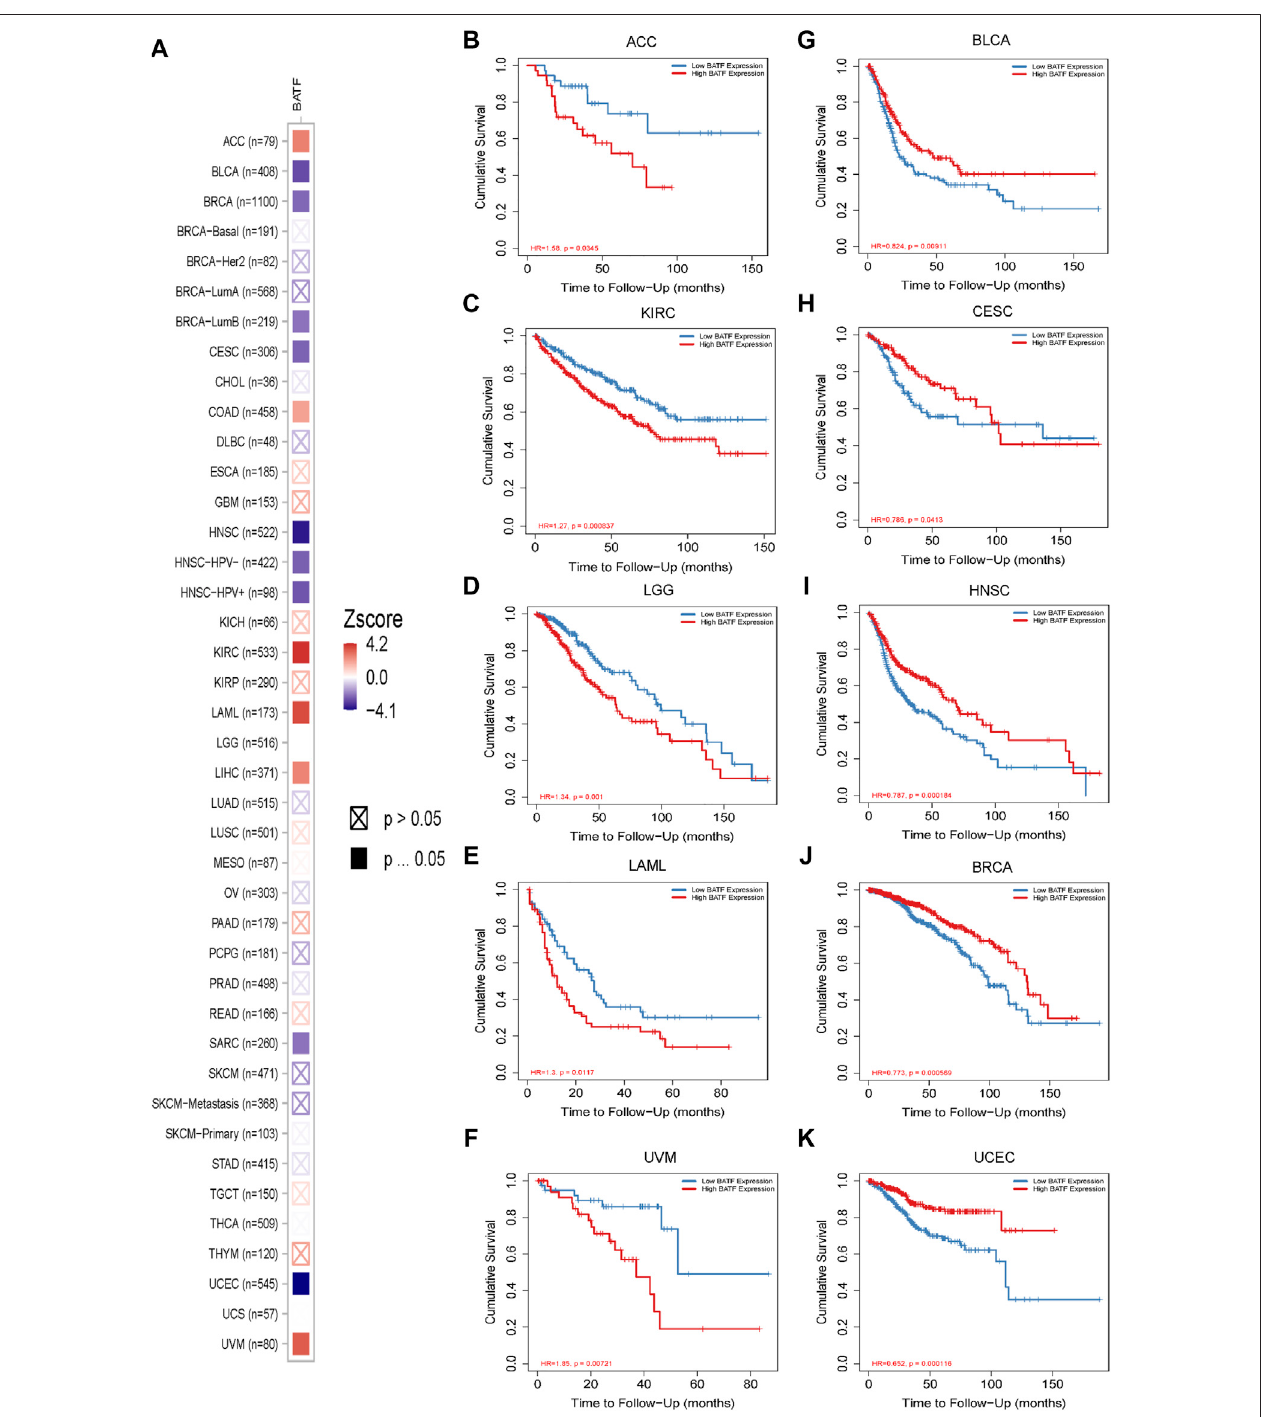
FIGURE 3 | Prognostic roles of BATF expression in tumors. (A) Cox regression analysis of BATF expression in pan-cancer. (B – K) Kaplan-Meier Plotter analysis of BATF expression in tumors.